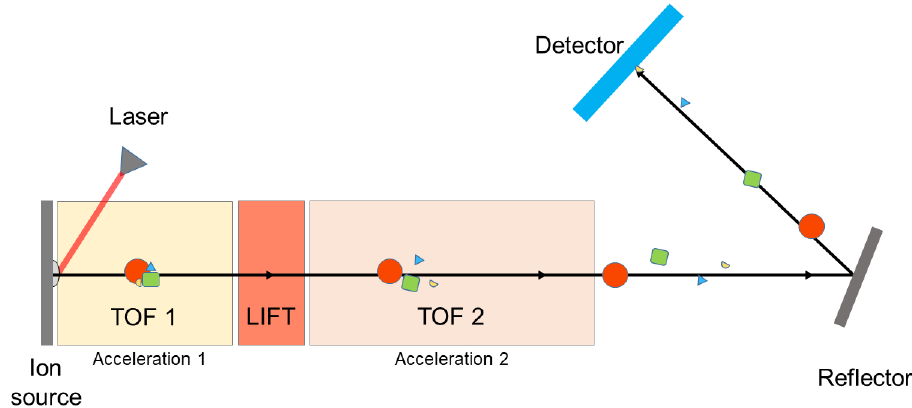
Figure 9. The principle of MALDI-TOF/TOF mass spectrometer.